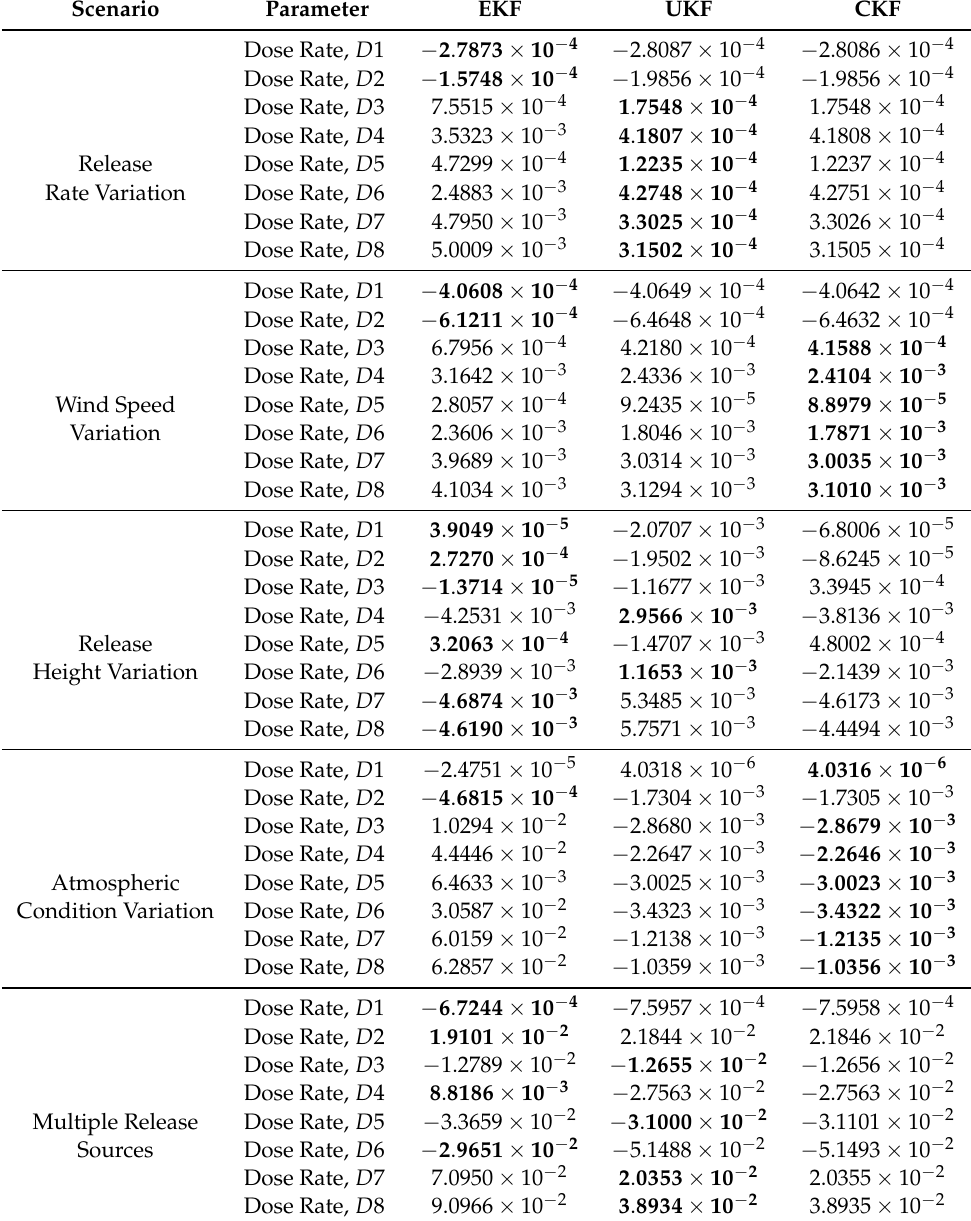
Table 4. Fractional bias between true and estimated dose rates for EKF, UKF, and